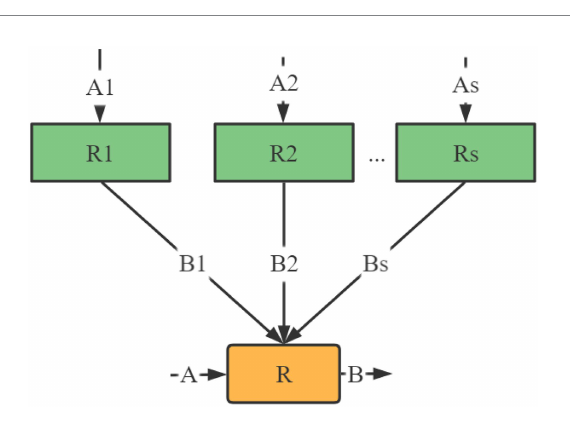
FIGURE 2 Flow chart of association rule mining.